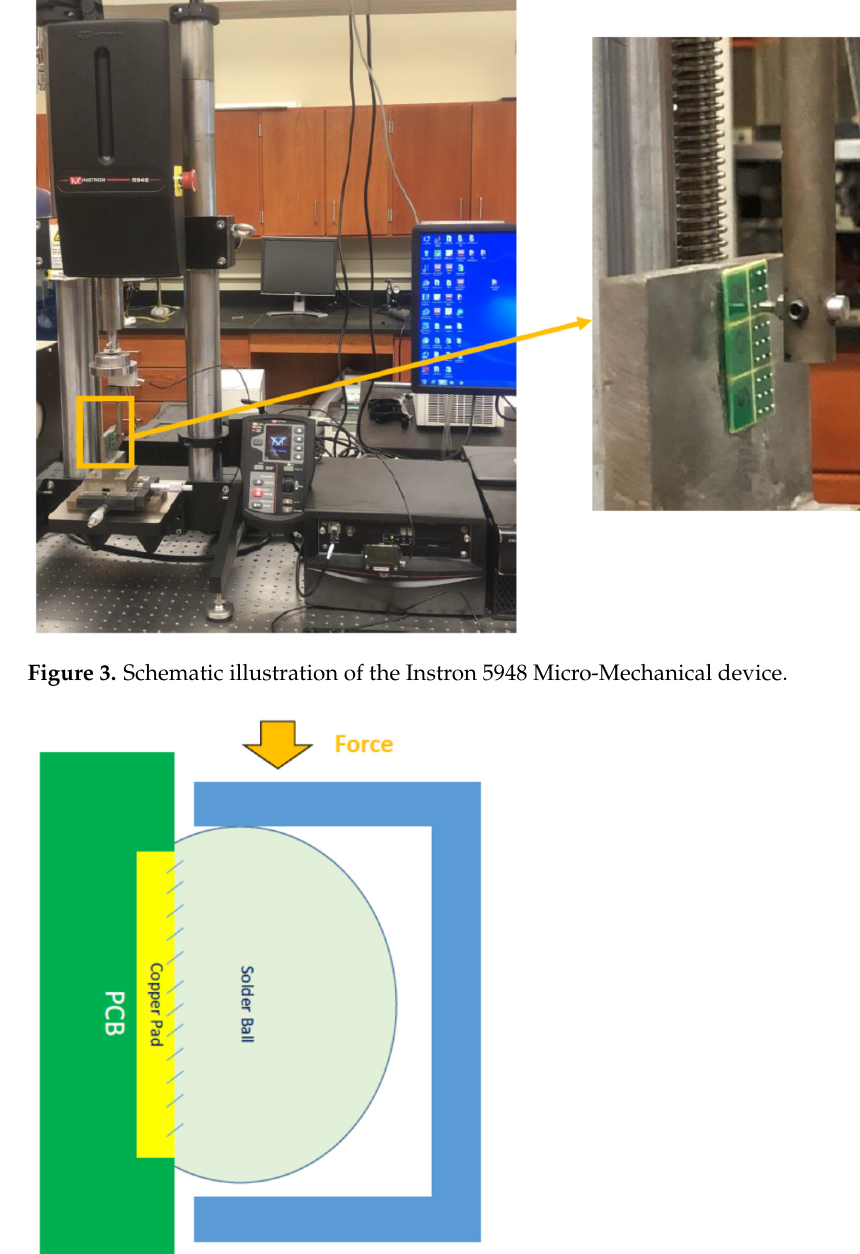
Figure 4. Schematic of shearing of the solder joint.